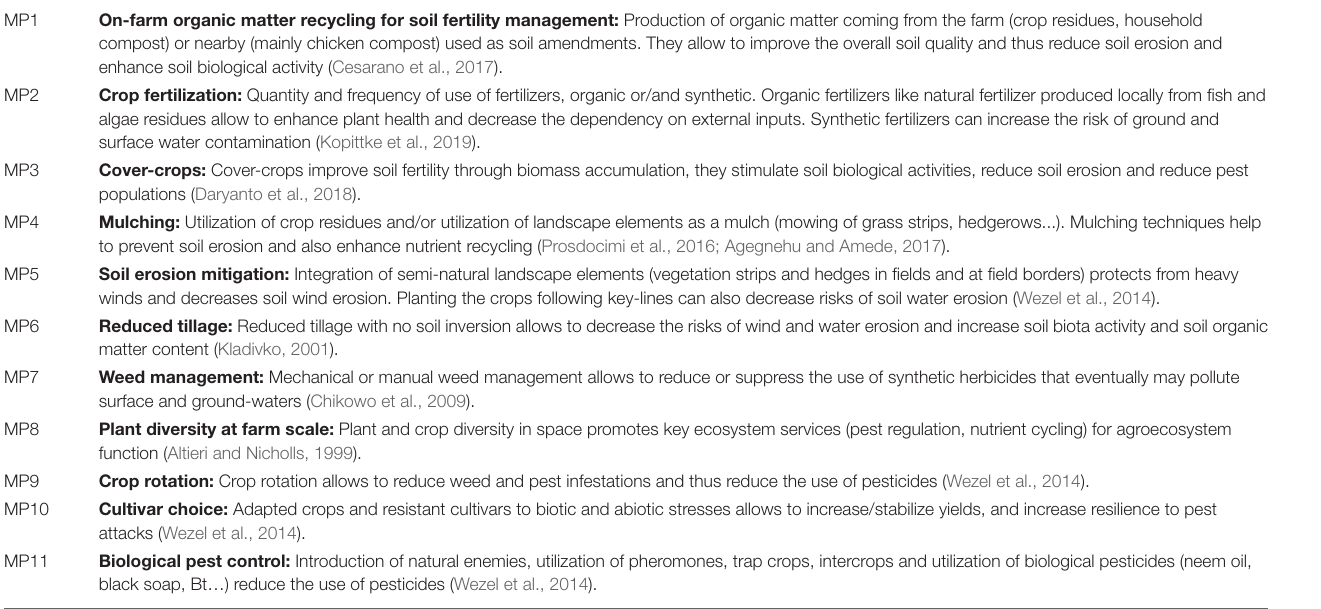
TABLE 1 | Characterization of the 11 management practices (MP) used by farmers and their benefits. MP1 On-farm organic matter recycling for soil fertility management: Production of organic matter coming from the farm (crop residues, household compost) or nearby (mainly chicken compost) used as soil amendments. They allow to improve the overall soil quality and thus reduce soil erosion and enhance soil biological activity (Cesarano et al., 2017). Crop fertilization: Quantity and frequency of use of fertilizers, organic or/and synthetic. Organic fertilizers like natural fertilizer produced locally from fish and algae residues allow to enhance plant health and decrease the dependency on external inputs. Synthetic fertilizers can increase the risk of ground and surface water contamination (Kopittke et al.,